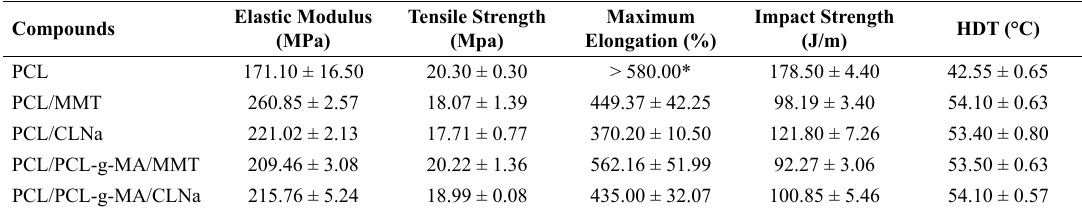
Table 4. Mechanical properties of PCL